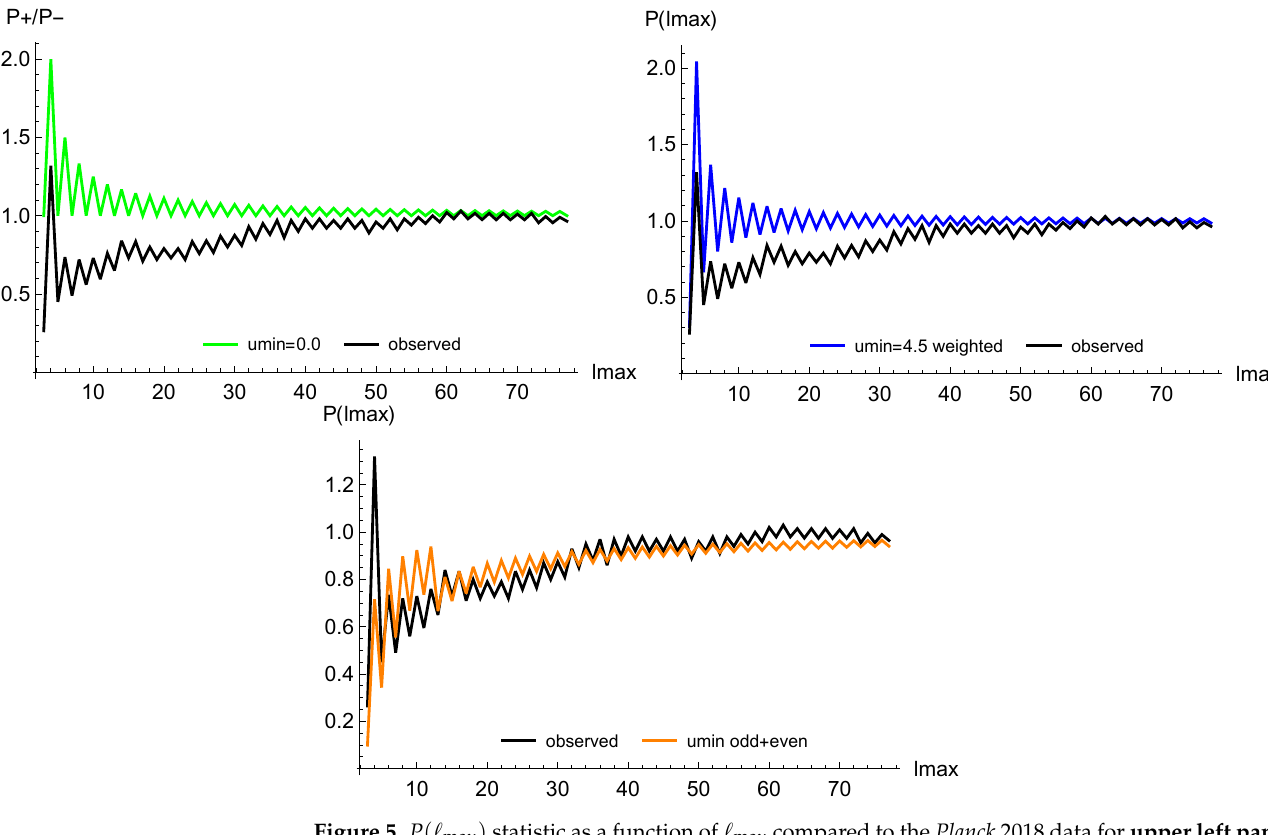
= 5.34 and u odd = max min